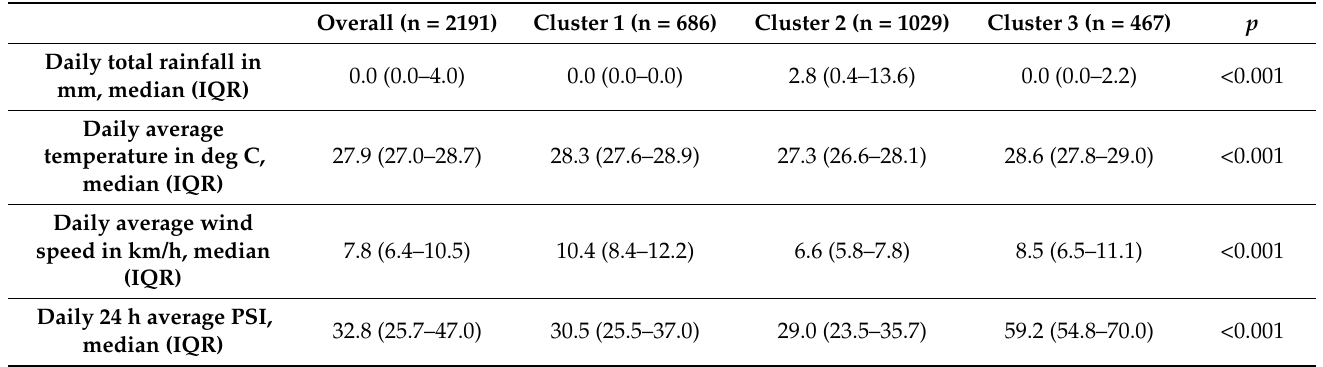
Table 1. Characteristics of the clusters (N = 2191 days).